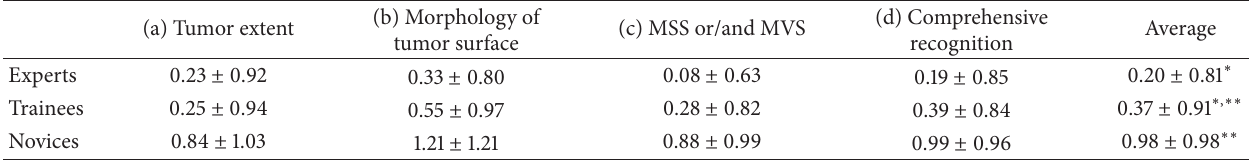
Table 3: Average improvement of Study 1 (average ± SD).